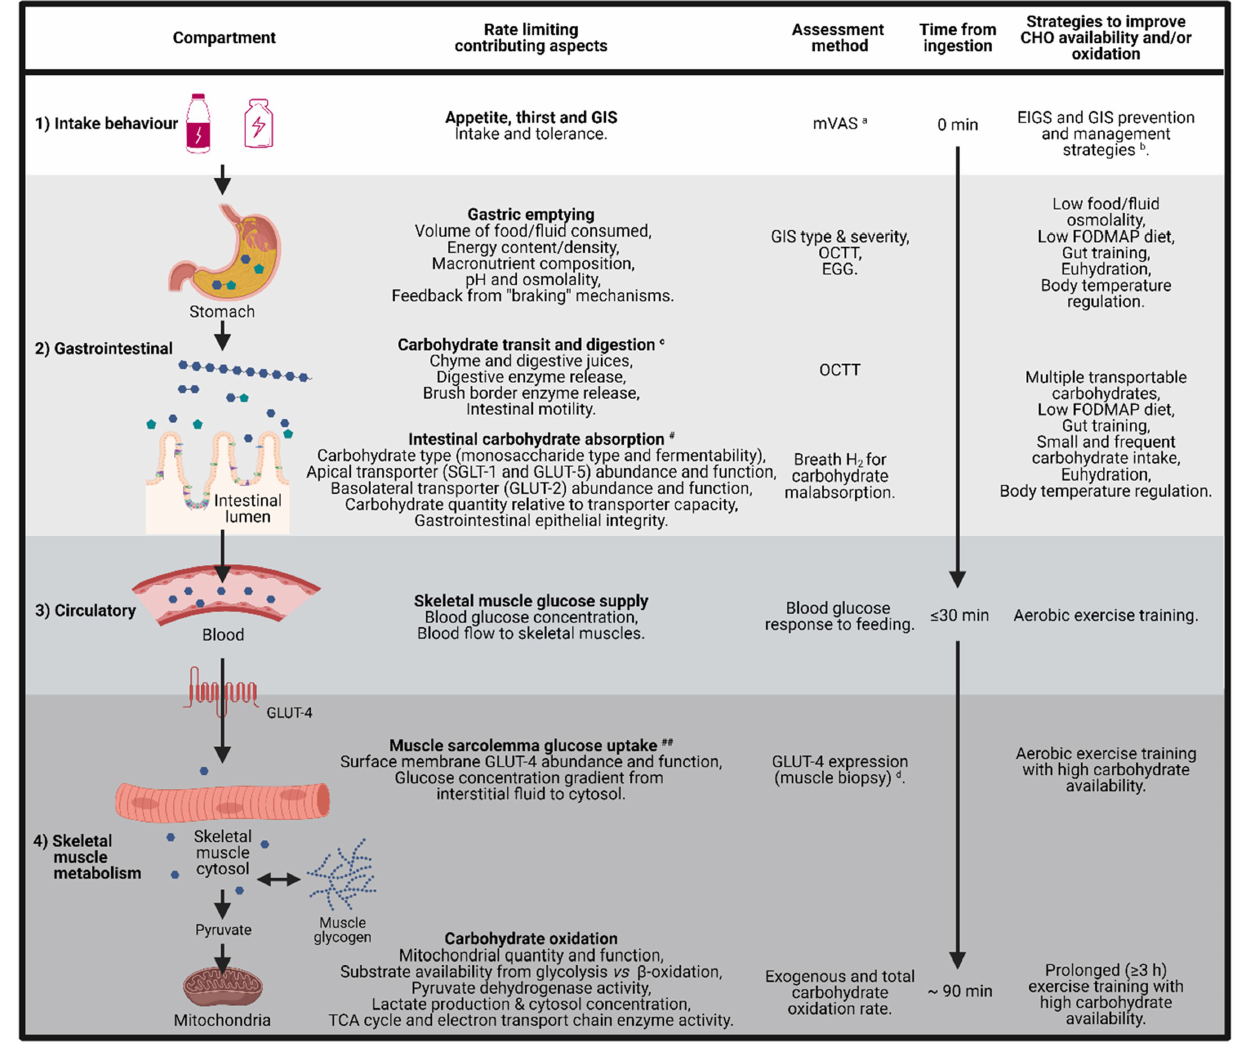
FIGURE 5 | Schematic illustration of the barriers and limitations to total carbohydrate availability and oxidation, from mouth to mitochondria, including the time course for carbohydrate uptake and oxidation, factors that limit each step, assessment method for quantification, and potential strategies to reduce these limitations. a Modified visual analogue scale (mVAS; Gaskell et al., 2019). b EIGS and GIS prevention and management strategies (Costa et al., 2017b, 2020b). c Gastrointestinal brake mechanisms: nutritive and non-nutritive residue along the small intestine, and inclusive of terminal ileum, results in neural and enteroendocrine negative feedback to gastric activity (Layer et al., 1990; Van Citters and Lin, 2006; Shin et al., 2013; van Avesaat et al., 2015; Miall et al., 2018). d GLUT-4 detection methods (McGee and Hargreaves, 2006; Flores-Opazo et al., 2020). # dependent on taste receptors (e.g., T1R3 and α -gustducin expressed in epithelial enteroendocrine cells) and gut hormones (e.g., GIP and GLP-1 that are activated by taste receptor stimulation – nutrient presence along the intestinal lumen) that regulate the SGLT-1 protein synthesis and translocation to the apical border of enterocytes (Rozengurt, 2006; Margolskee et al., 2007; Shirazi-Beechey et al., 2011). ## Dependent on magnitude of skeletal muscle blood perfusion, sarcolemma GLUT-4 concentration, GLUT-4 saturation, cytosol Ca 2+ flux, glycolytic enzyme concentration and activity (i.e., intramuscular glucose metabolism gradient; Hargreaves and Spriet, 2020). EGG, electrogastrography and OCTT, orocecal transit